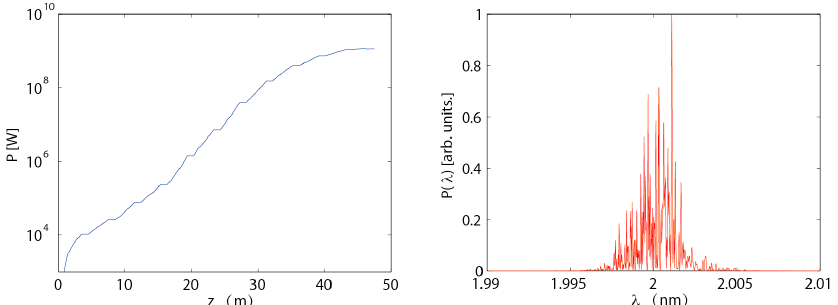
Figure 16. Simulated FEL performance of the SASE line at 2 nm output: gain curve and the output pulse in the time